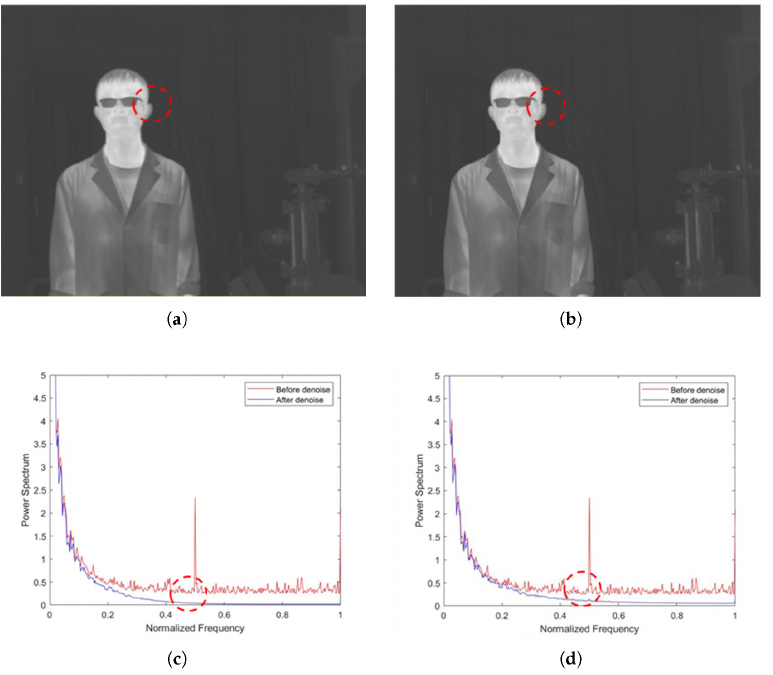
Figure 7. Denoising effects of ablation experiment on an image of a person: ( a ) non-AEPO; ( b ) our approach; ( c ) non-AEPO; ( d ) our approach.